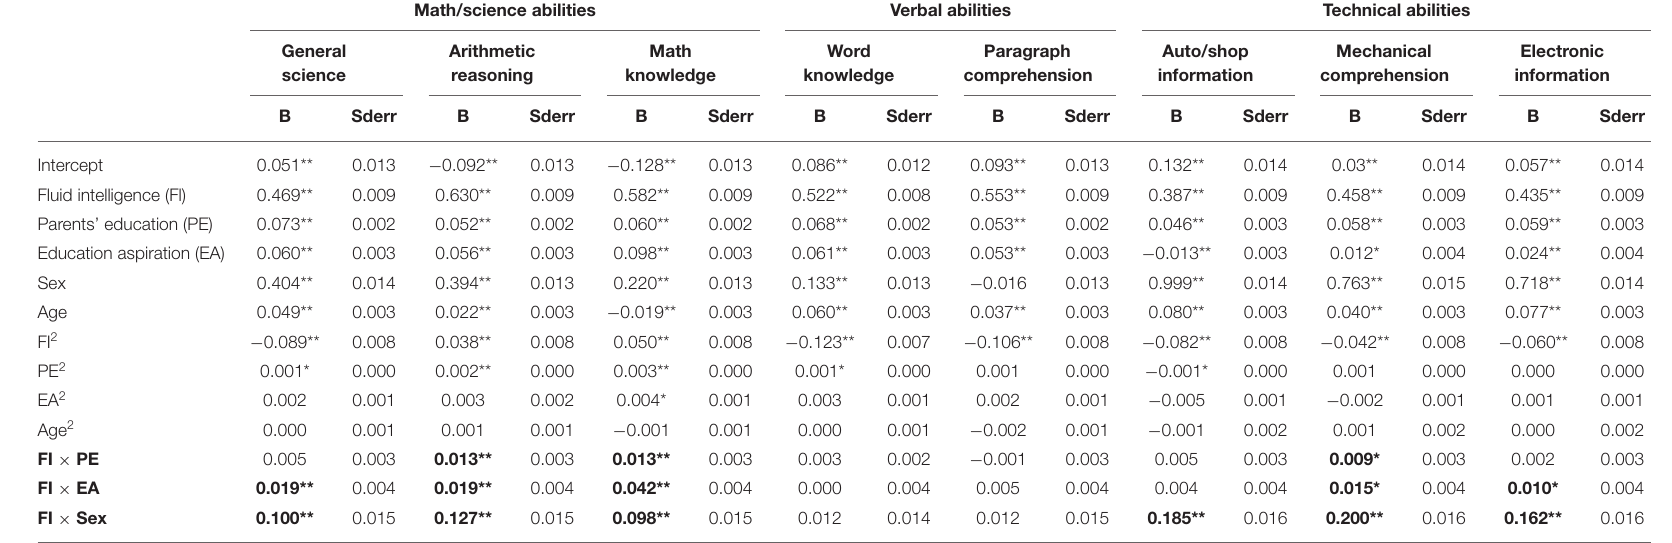
TABLE 3 | Regressions of crystalized